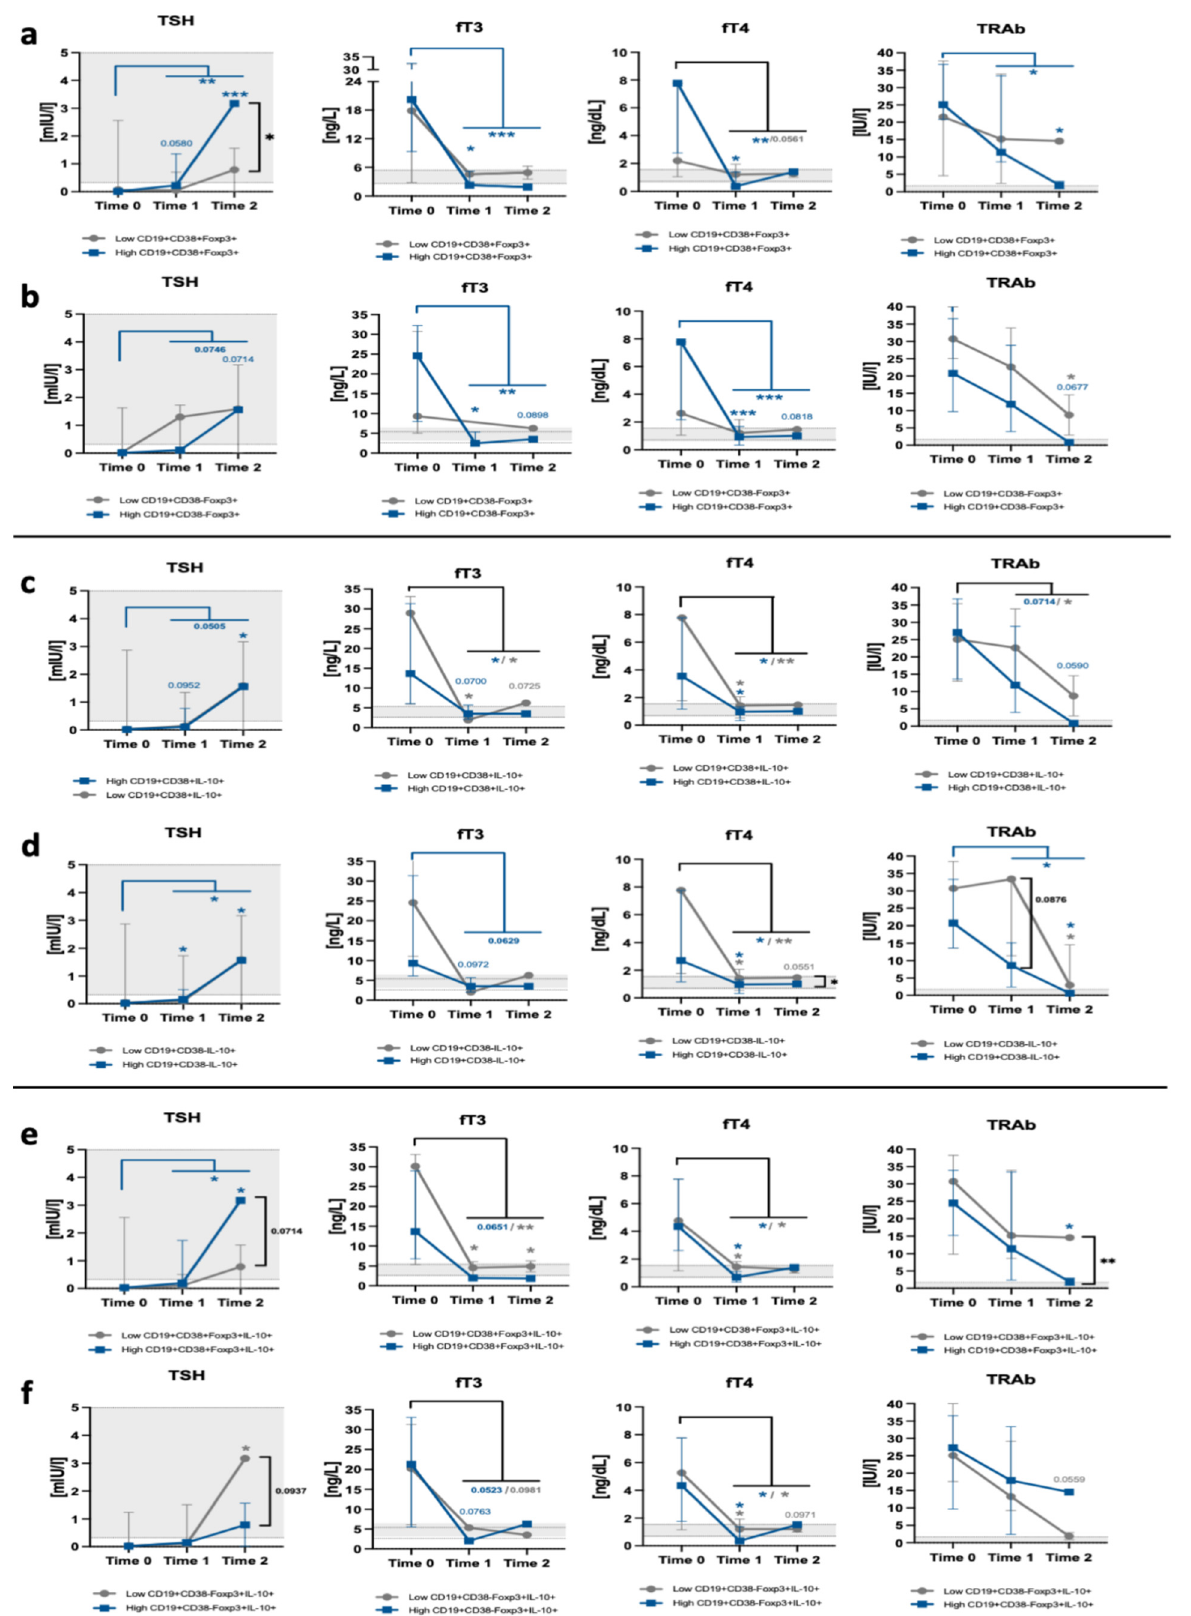
Figure 5. Monitoring of initial regulatory B cell levels’ significance in the context of Graves’ patients’ response to methimazole treatment. Graves’ subjects were stratified into low- (grey lines) and high-Breg (blue lines) groups and monitored at